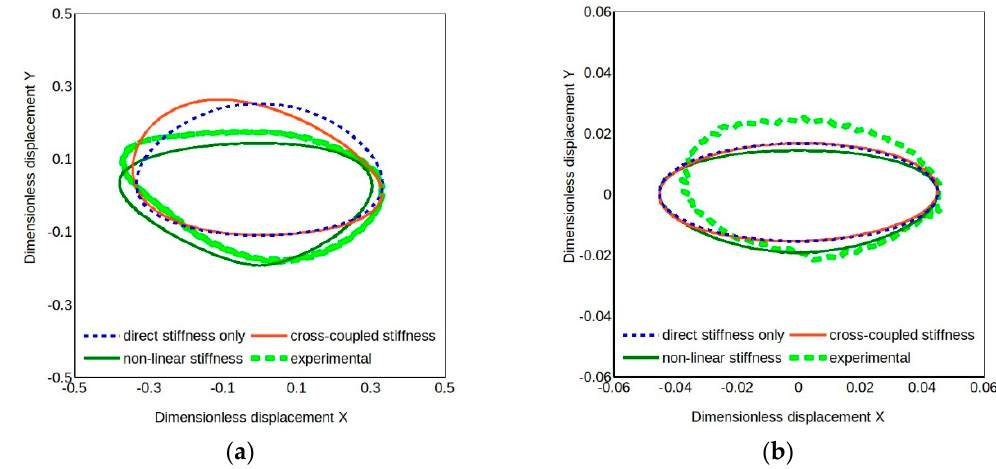
Figure 11. Calculated and experimental orbits of the five-pad TPJB for three different models with load dependent stiffness coefficients and two loads (L3<L2): ( a ) L3-26%, ( b ) L2-3%.